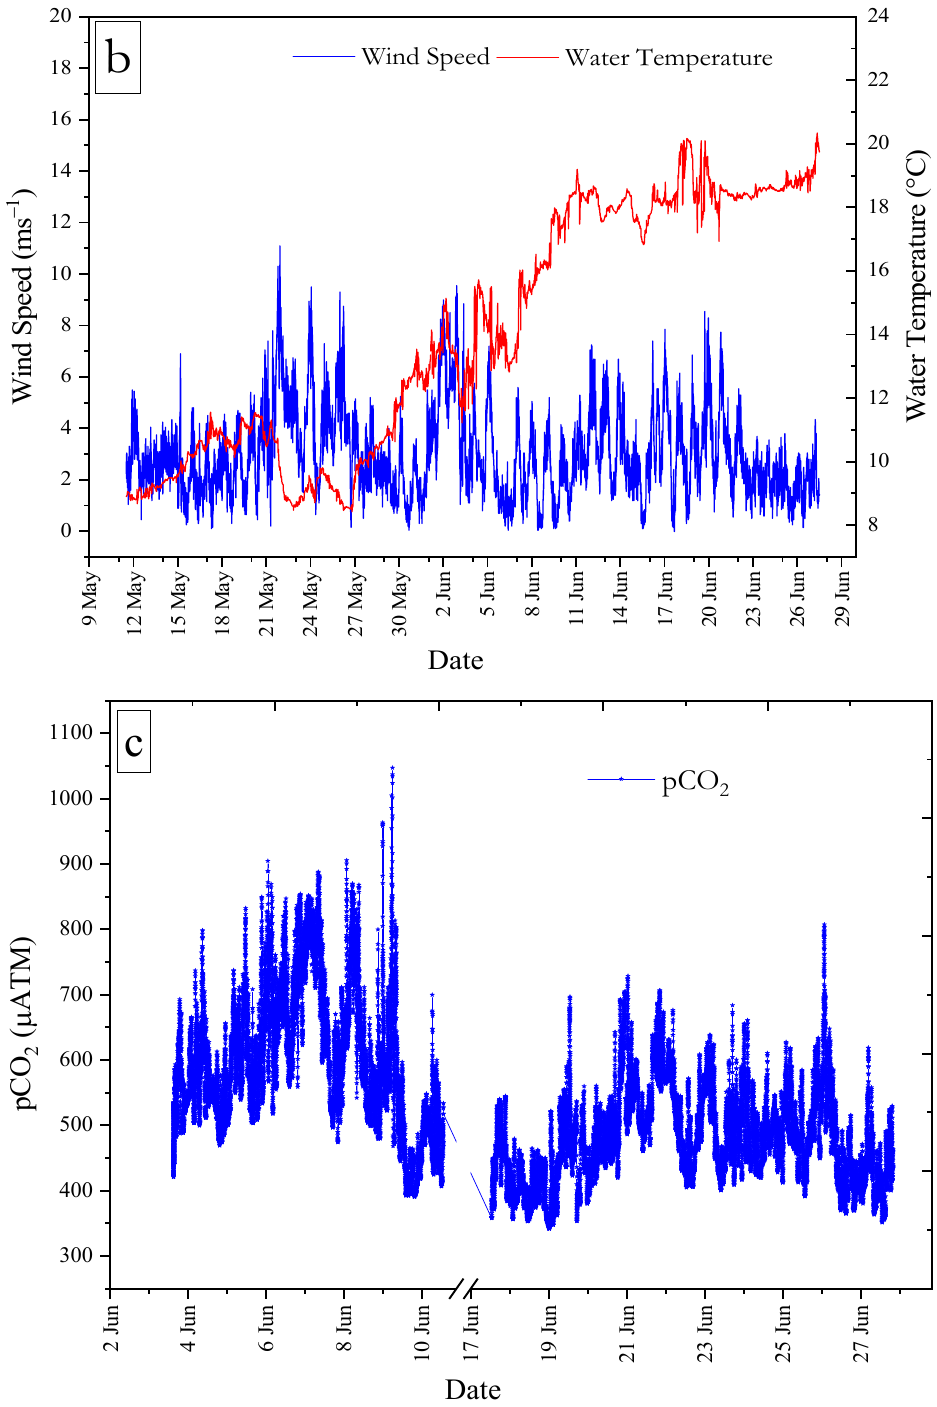
Figure 7. ( a ) Thirty-day time series (28 May to 28 June 2021) of the environmental parameters at Kiel Fjord including dissolved oxygen (DO) (black), salinity (blue), and temperature (red) at a 1 min sampling frequency ( n = 32,820) recorded by the YSI sensor deployed near the AutoLAb analyzer intake. ( b ) Time series data from the period 12 May to 26 June 2021, for wind speed (blue lines, left Y-axis) and water temperature (red lines, right Y-axis) obtained from GEOMAR weather metrological station. ( c ) Time series data from the period 28 May to 27 June 2021 from CONTROS HydroC-CO 2 for pCO 2